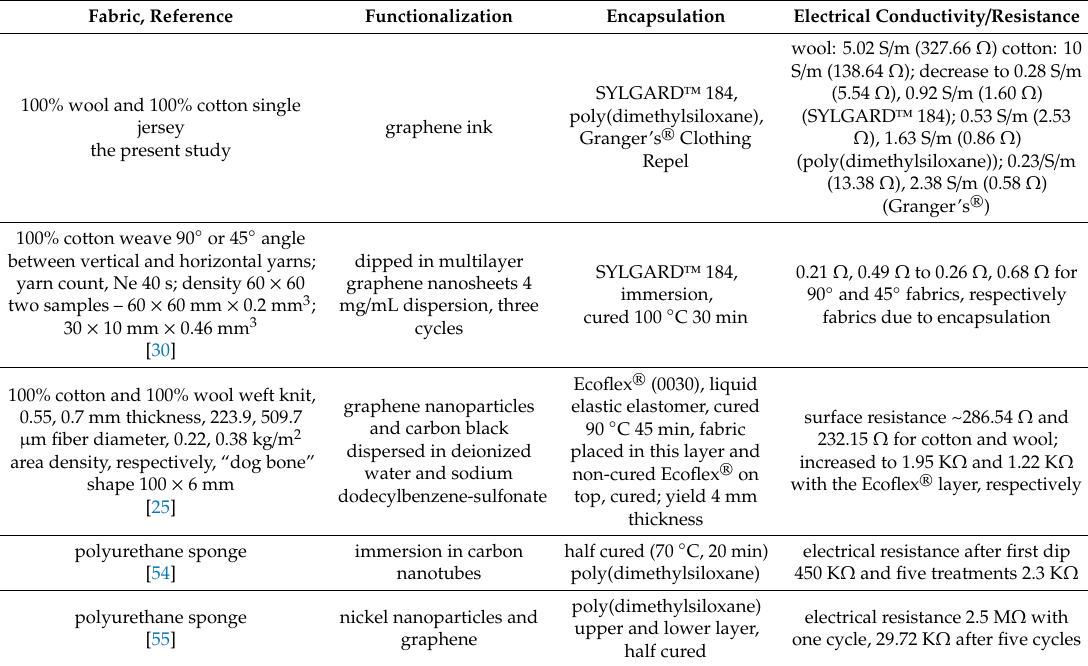
Table 5. Electrical conductivity of graphene treated and poly(dimethylsiloxane) functionalized fabrics. Fabric, Reference Functionalization Encapsulation Electrical Conductivity / Resistance